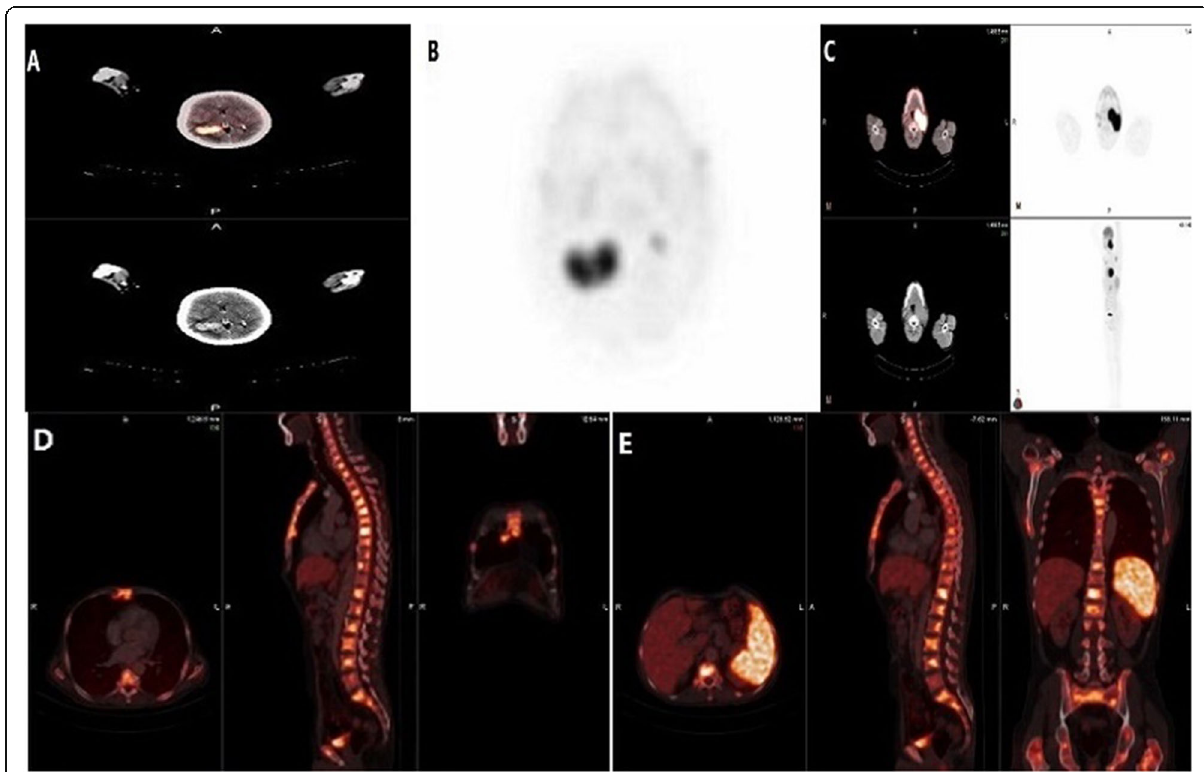
Fig. 5 A 58-year-old male with two metastatic mass lesions in the right parietal lobe. a , b Axial fused PET/CT and multiplanar PET scan showed two metastatic lesions in the right parietal lobe with active FDG uptake. c Axial fused PET/CT and CT scan showed an active mass in the left nasopharynx proved by nasopharyngoscopic biopsy to be nasopharyngeal carcinoma. d , e Multiplanar fused PET/CT scan showed cervical, dorsal, and lumbar vertebral bodies with increased metabolic activity indicating metastatic lesions; also, metastasis were seen in the spleen and in the